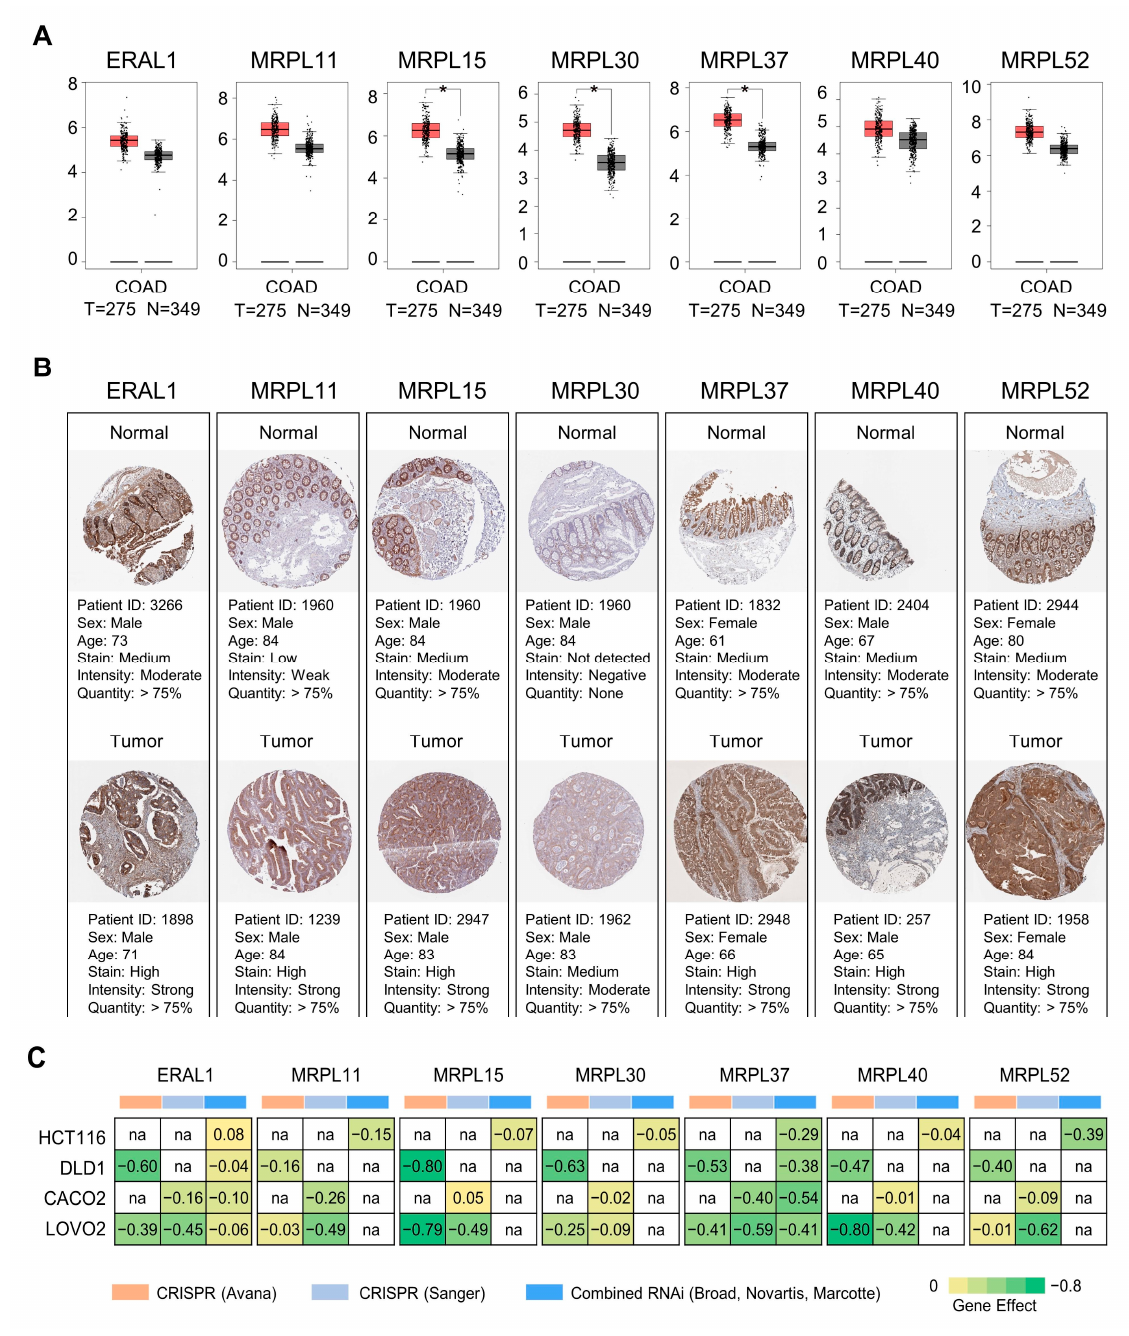
Figure 6. Validation of seven hub proteins as potential targets in berberine-treated colon cancer cells. ( A ) Validation of hub proteins in the transcriptional level by Gene Expression Profiling Interactive Analysis (GEPIA) [43]. T and N represents 275 tumor tissues and 349 normal tissues, respectively. * p < 0.05. ( B ) Validation of hub proteins in the translational level. Immunohistochemistry (IHC) staining data were obtained from the Human Protein Atlas (HPA) database, which demonstrated the expression status of hub proteins and the patient data [44]. ( C ) Dependency scores for seven hub proteins in four colon cancer cell lines from the Cancer Dependency Map (DepMap) [45,46]. Color groups indicates different sources of data; a lower score of gene effect means that a gene is more likely to be dependent on a given cell line; a score of 0 is equivalent to a gene that is not essential whereas a score of − 1 corresponds to the median of all common essential genes.